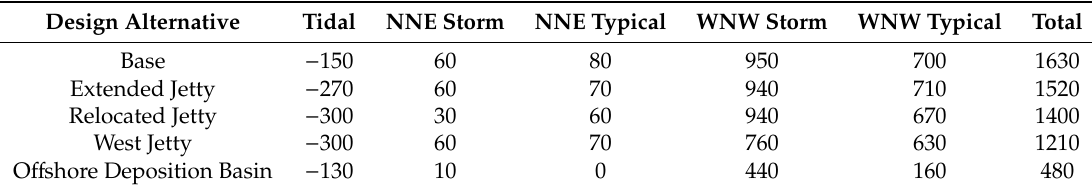
Table 10. Annualized net volume change within channel limits (m 3